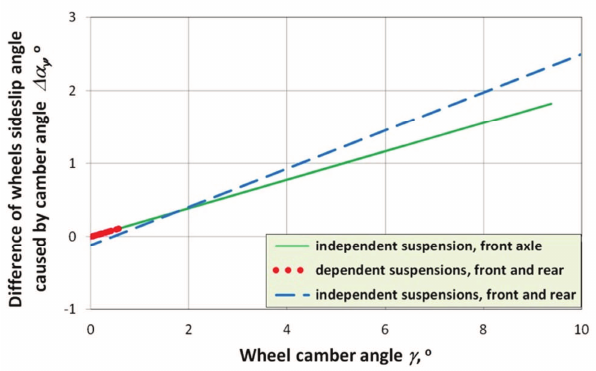
Fig. 13. The influence of camber angle g on the difference of wheels side slip angle – Da [own